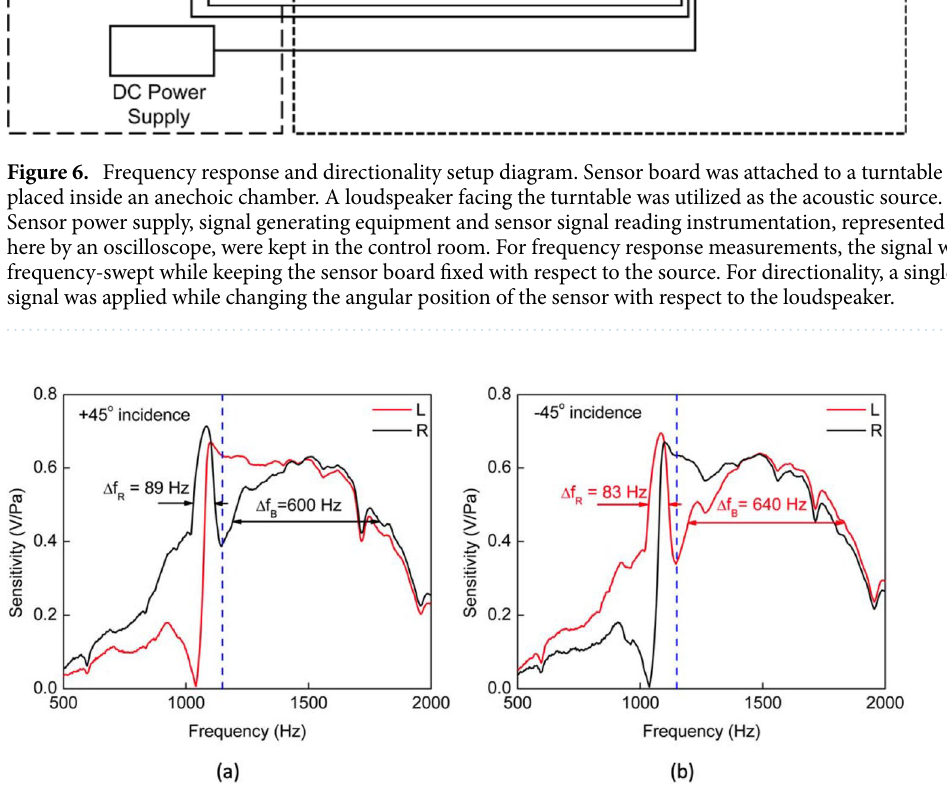
amplitudes or on the resulting phase shift as a function of incident angle, a single tone acoustic signal with fre- quency between the rocking mode and bending mode resonance peaks was chosen (1150 Hz). This frequency was chosen because it results in the greatest wings’ oscillation amplitude difference near the rocking mode. Figure 8a shows recorded waveforms from the two wings at normal incidence of sound. As expected, there is no phase or amplitude difference between the two signals since at normal incidence only the bending mode can be excited and the wings oscillate in phase. The waveforms on Fig. 8b were recorded for a 30°-incident sound wave. It clearly shows that the amplitudes and phases associated with the two wings are not the same due to coupling between the rocking and bending modes. For other angles of incidence, waveforms were recorded by rotating the turntable from − 90° to + 90° in 10° steps while keeping the same excitation amplitude (sound pressure level) and frequency. From the recorded waveforms, the phase shift between left and right signals was determined using their zero crossings. In order to compare direction of arrival (DOA) obtained from the phase shift with that of the amplitude ratio, the two signals, left (L) and right (R) were used to construct the auxiliary signals “sum” (L + R) and “difference” (L − R) for every turntable position.